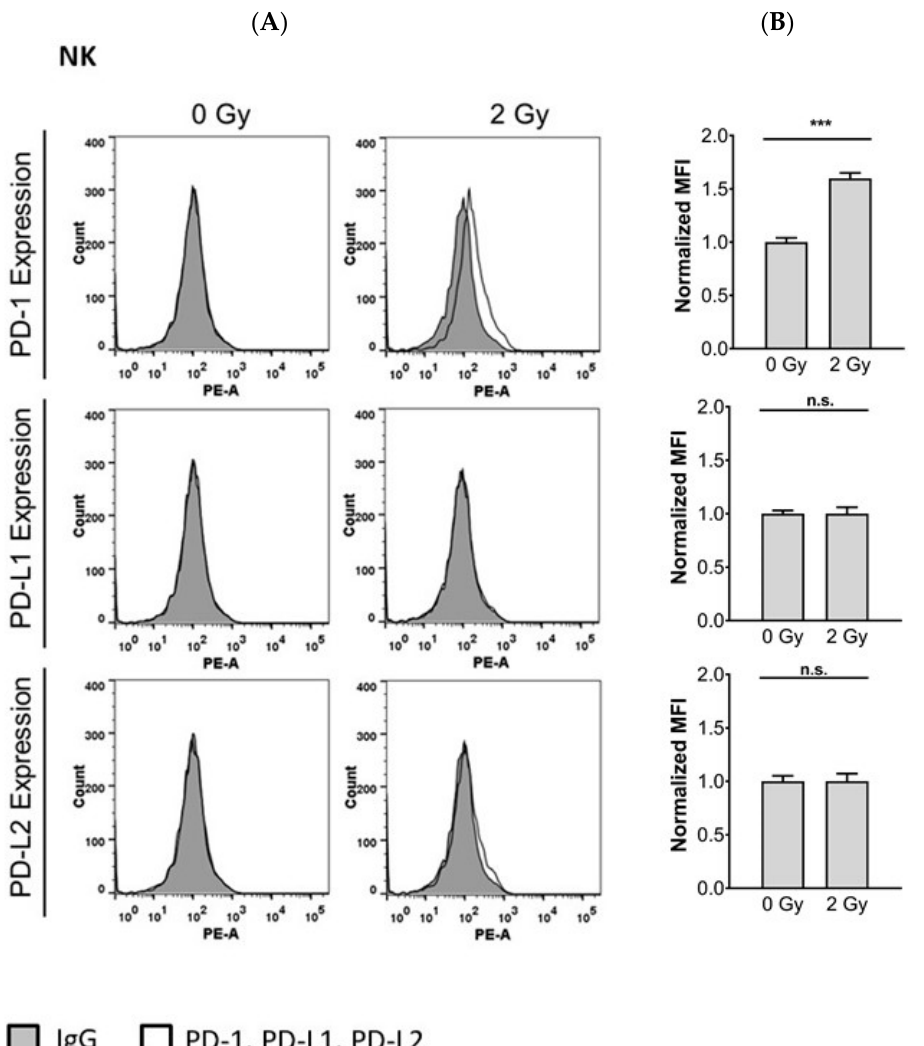
Figure 4. Radiotherapy upregulates surface expression of PD-1 in NK cells. Cells were irradiated with 2 Gy. After 24 h PD-1, PD-L1, and PD-L2 expression was analyzed by flow cytometry. ( A ) Histogram plots of PD-1, PD-L1 and PD-L2 expression on NK cells; ( B ) quantification of PD-1, PD-L1 and PD-L2 expression on NK cells. Quantitative data of three independent experiments are shown as normalized mean fluorescence intensity (MFI). Data of normalized MFI is calculated by dividing the MFI of the sample stained by the antibody of interest by the MFI of the control antibody. Data is shown as mean ± S.E.M. Asterisks indicate statistically significant differences between all cell lines (one-way ANOVA; *** p < 0.001; n.s.: not significant).